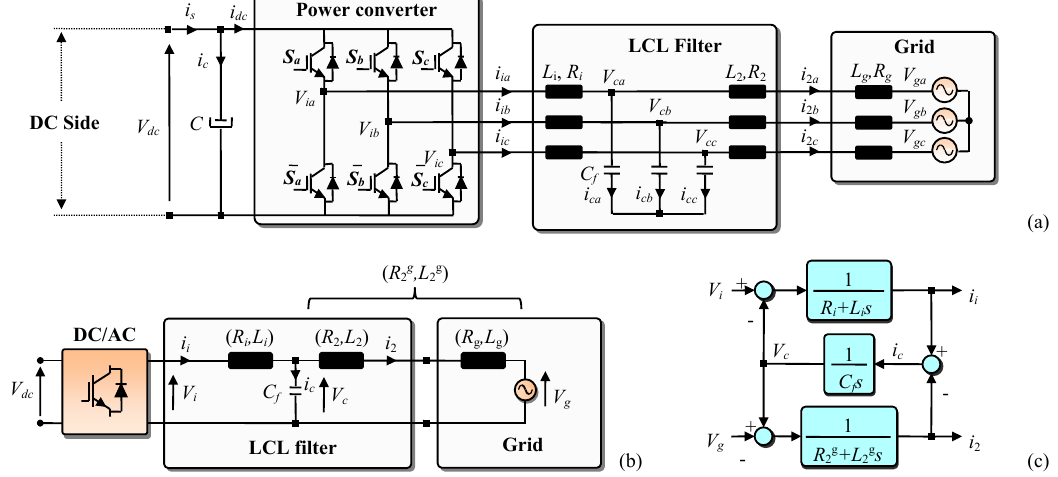
Figure 1. ( a ) Power circuit of the three phase grid connected power converter with LCL filter; ( b ) single phase equivalent circuit; ( c ) block diagram of the LCL filter.